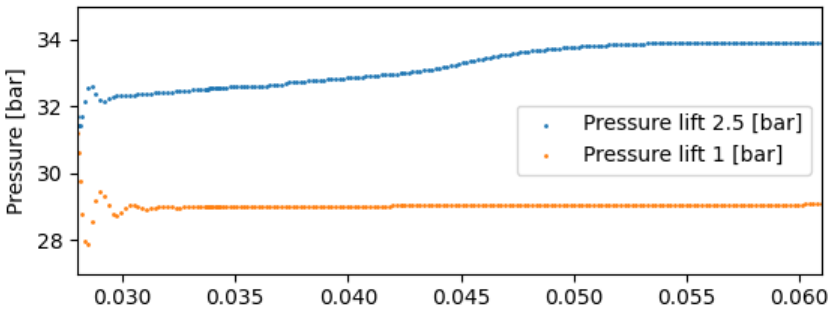
Figure 11. Pressure variation along the mixing-chamber center line for simulations N4 and